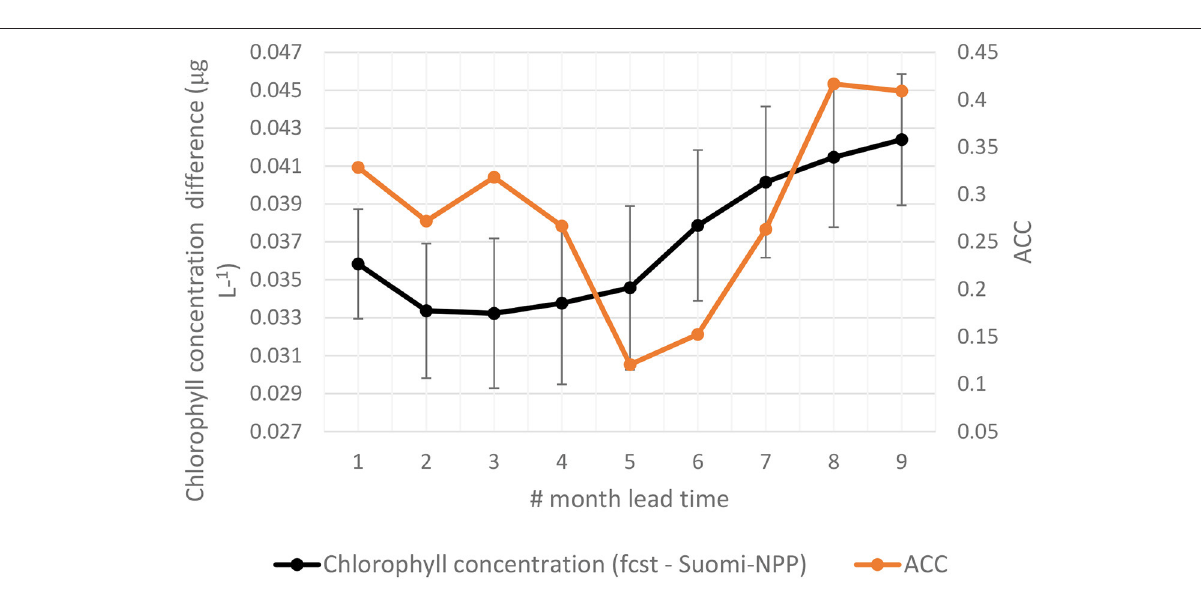
Frontiers in Marine Science |